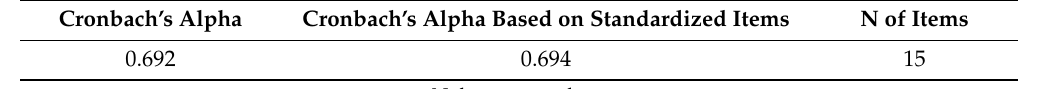
Table 4. Results of reliability test (Cronbach alpha) (n =